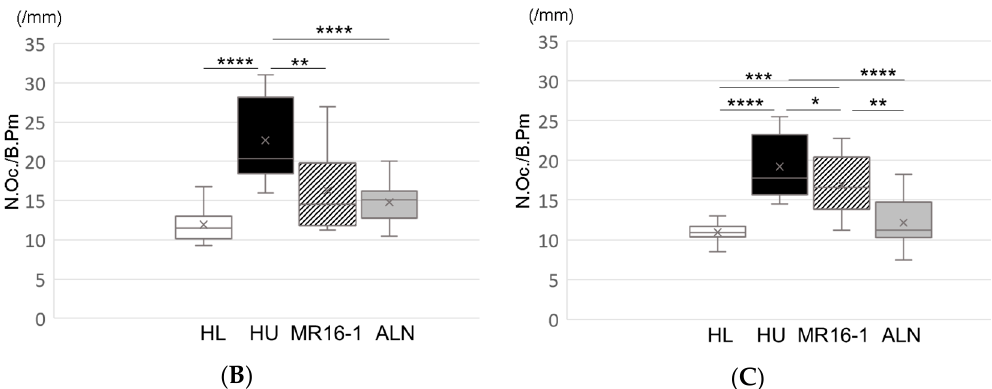
Figure 4. Histological analysis of hindlimb bone: Tartrate-resistant acid phosphatase (TRAP) staining of the proximal tibial metaphysis, Scale bar is 100 µ m ( A ). Histological analysis of the number of osteoclasts / bone perimeter (N.Oc. / B.Pm) in the distal femoral metaphysis ( B ) and the proximal tibial metaphysis ( C ) ( / mm). Top, bottom, and middle lines of the graph correspond to the 75th percentile, 25th percentile, and median, respectively. Cross represents mean. Each circle represents an outlier ( n = 8 in each group). * p < 0.05, ** p < 0.01, *** p < 0.005, and **** p < 0.001.